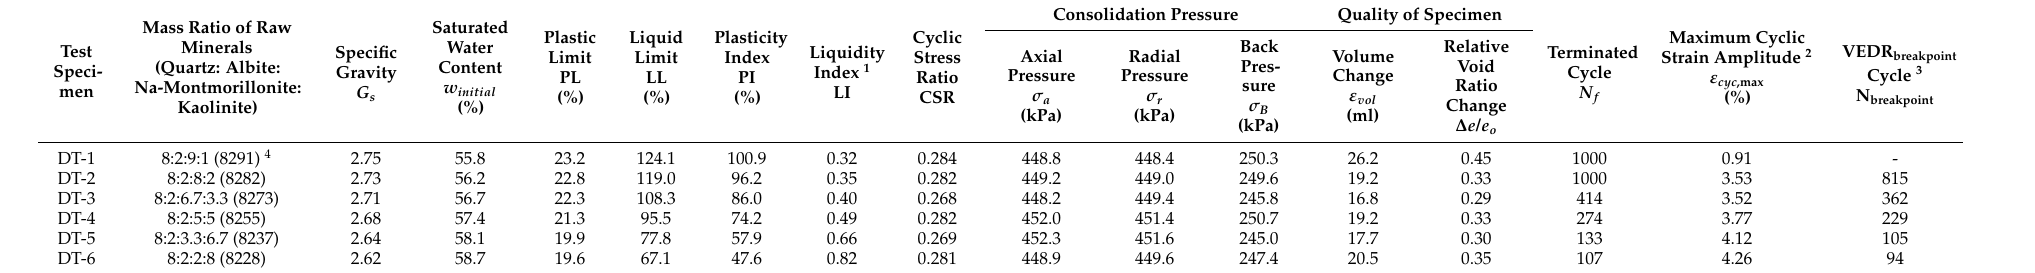
Table 5. The parameters of laboratory dynamic triaxial testing of artificial marine